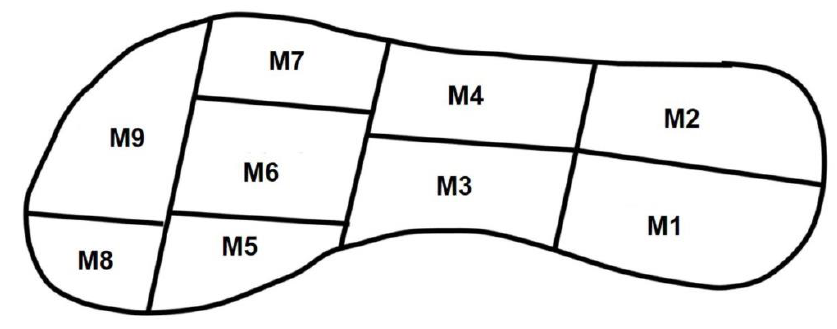
Figure 1. Insole masks. M1 (medial heel), M2 (lateral heel), M3 (medial midfoot), M4 (lateral midfoot), M5 (medial forefoot), M6 (central forefoot), M7 (lateral forefoot), M8 (great toe), and M9 (lesser toes).